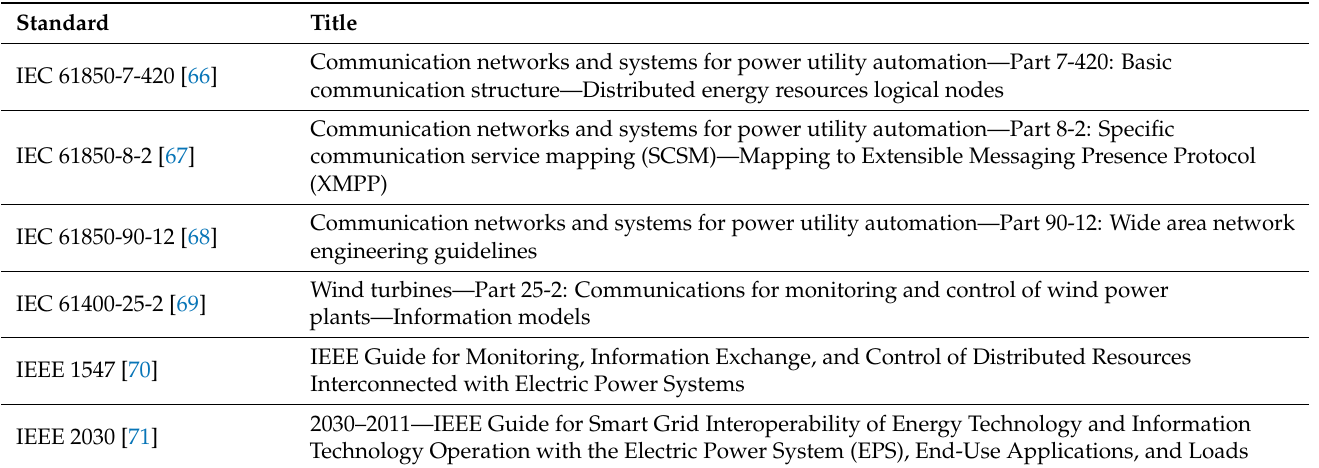
Table 9. Standards related to the communication systems of MGs.